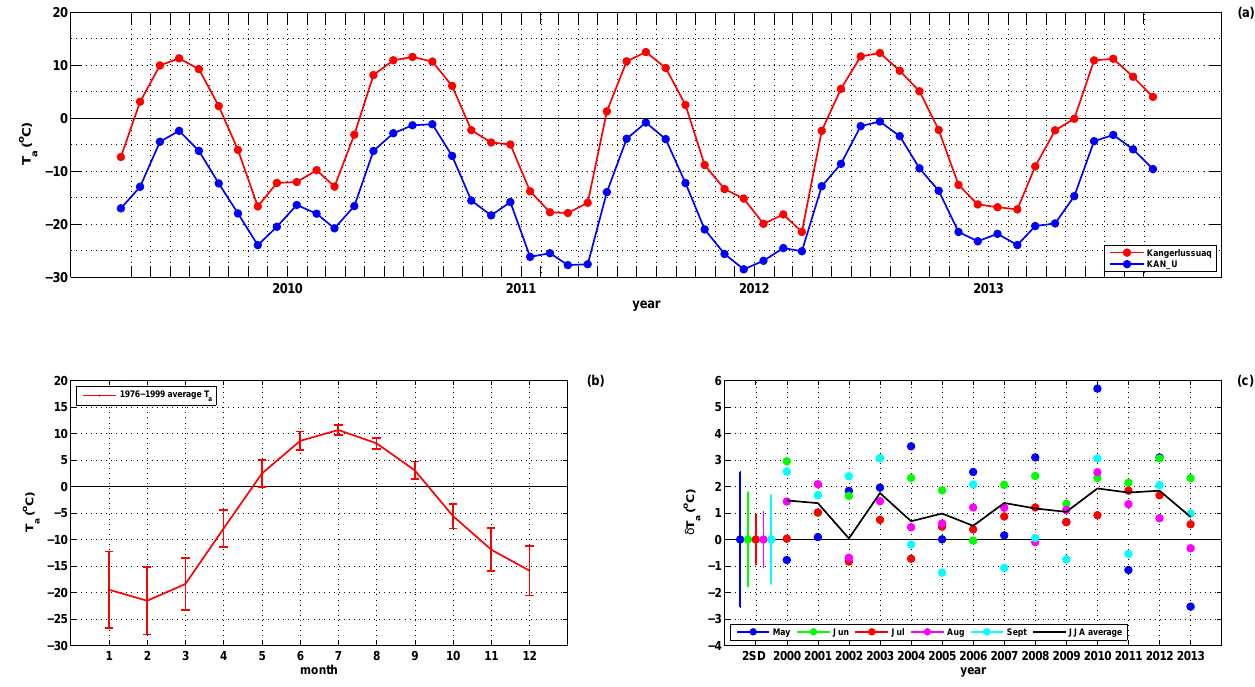
Figure 12. (a) Monthly air temperature at Kangerlussuaq and at KAN_U. Correlation coefficients ( R ): 0.97 for the extent of the KAN_U data and 0.66–0.99 for the months individually, with the minimum being January. (b) Monthly reference period (1976–1999) air temperature at Kangerlussuaq. (c) Monthly (May to September) and summer (June–July–August average) air temperature anomalies at Kangerlussuaq for the years 2000–2013. Error bars indicate 2 standard